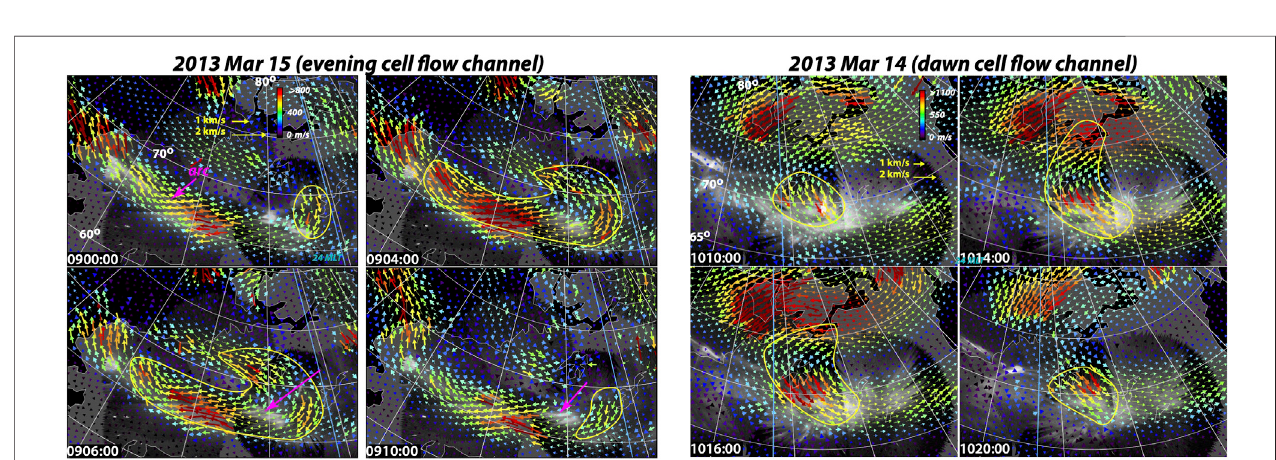
FIGURE 6 | Same as Figure 4 , except the left- and right-hand sides, respectively, show an example of a fl ow channel appearing to enter the auroral oval from the polar cap and becoming primarily within the dusk (March 15, 2013) and dawn (March 14, 2013) convection cell. The closed yellow curves approximately encircle the region of the equatorward fl ows and where fl ows were enhanced relative to that seen in the fi rst panel for each